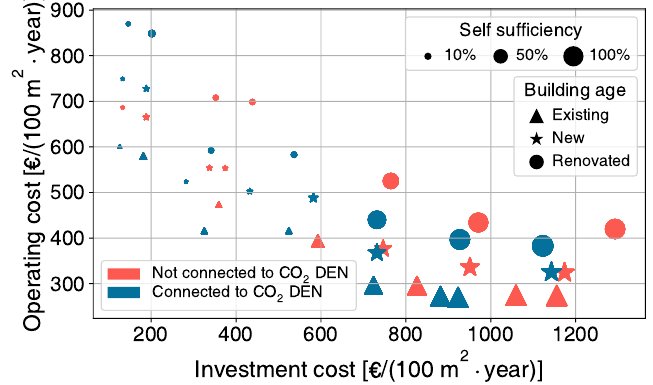
Figure 4. Systematic generation method for each building type (i.e., age and renovation).